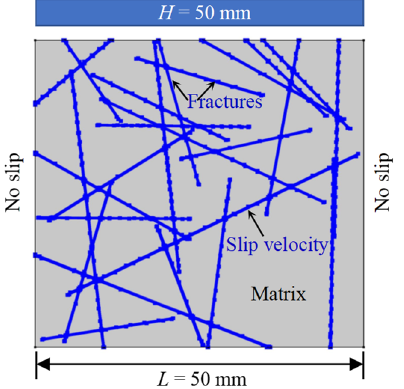
Figure 5. Domain settings and simulation conditions. The blue domains denote the fractures, while the gray domains represent the rock matrices with micropores. Methane flows into the system from the top and flows out from the bottom; the flow conditions are “no slip”.